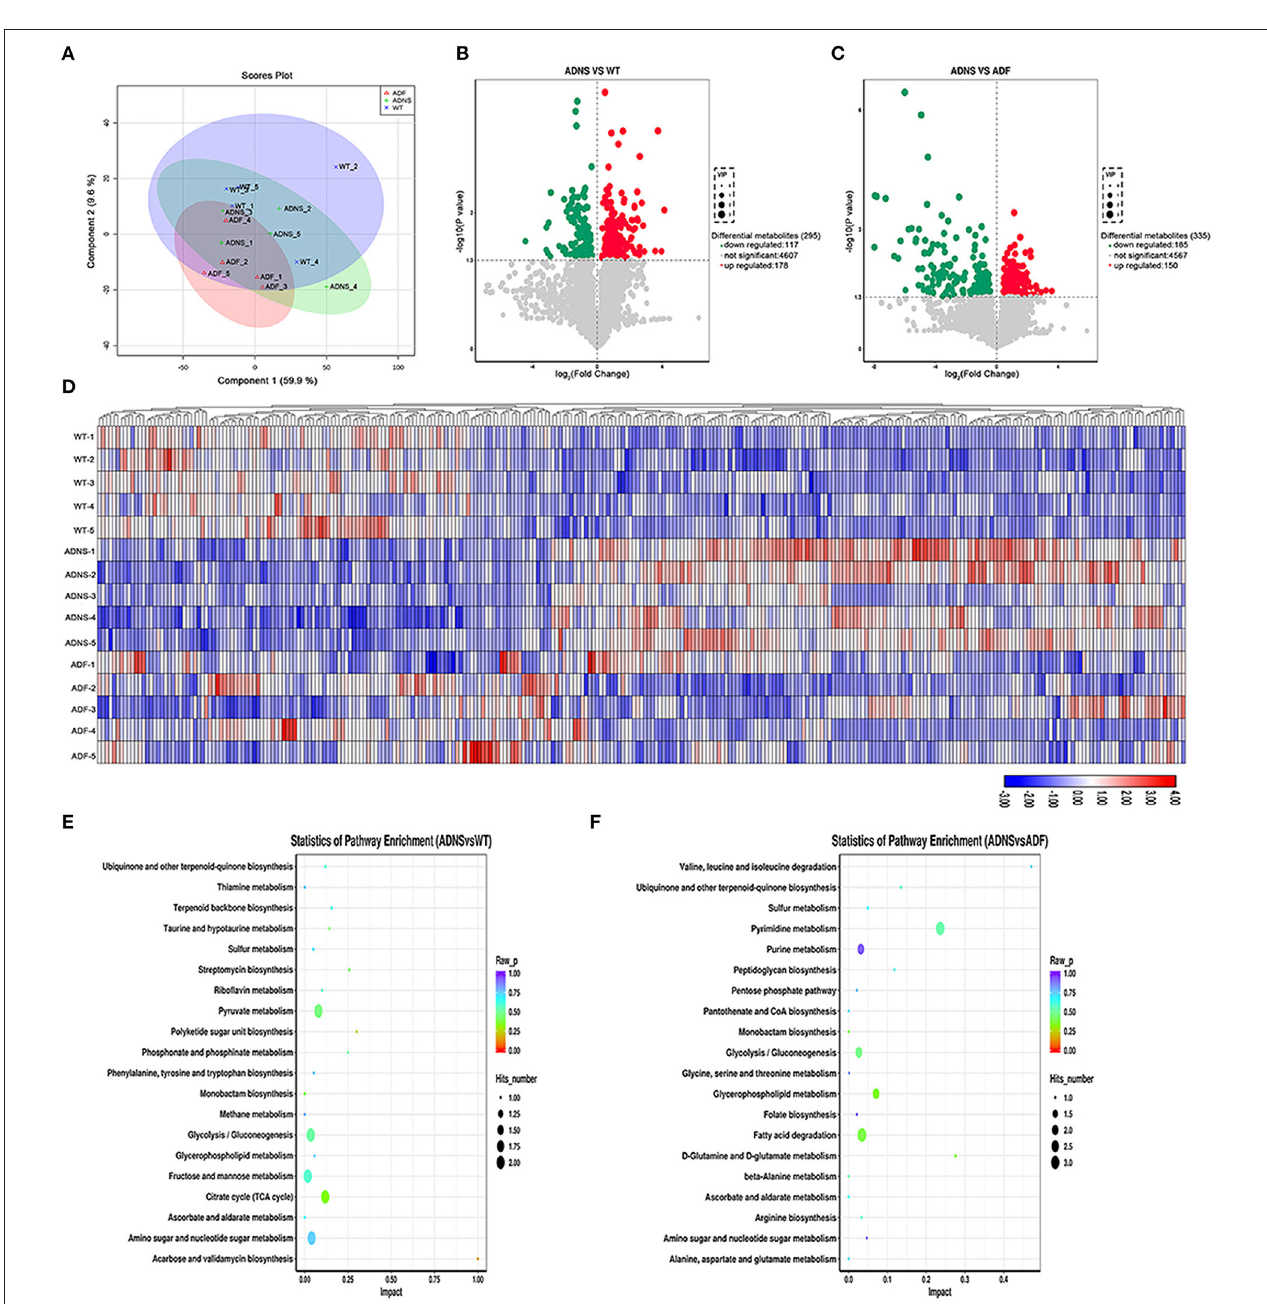
FIGURE 6 | Intestinal metabolite alteration of APP/PS1 mice treated with fasudil. (A) The PLS-DA score plots of metabolic profiles in WT (blue) and APP/PS1 mice treated with saline (ADNS, in green), or fasudil (ADF, in red). The separation trend of metabolic changes was observed in ADNS, WT and ADF; all samples were analyzed with 95% confidence interval (CI). (B,C) Volcano diagram of the changes in metabolites in WT, ADNS, and ADF mice. There were 295 metabolites differentially expressed in ADNS vs WT (B) , including 117 metabolites significantly downregulated (green) and 178 metabolites significantly upregulated (red) (metabolites with non-significant differences are shown in gray). In addition, there were 335 metabolites differentially expressed in ADF vs. ADNS (C) , including 185 downregulated metabolites and 150 upregulated metabolites. Each point in the volcano diagram represents a single metabolite. The scatter color represents the final screening result. (D) The heat map by the Hierarchical Clustering Analysis for different comparison combinations with significant changes. ADNS (middle 1–5) was presented in a different color pattern relative to WT (upper 1–5), which was similar to ADF (lower 1–5). (E,F) Analysis of the top 20 metabolic pathways in comparison combinations according to the impact factors (bubble plot). The results of the metabolic pathway analysis were presented as bubble plots. The bubble color represents the p value of the enrichment analysis, while the size of the point represents the number of different metabolites enriched in the pathway. Compared to WT, ADNS was focus on the metabolisms of pyruvate, glycolysis/gluconeogenesis, fructose, mannose, citrate cycle (TCA cycle), amino sugar, and nucleotide sugar; compared to ADNS, ADF was focused on the metabolisms of pyrimidine, purine, glycolysis/gluconeogenesis, glycerophospholipid, and fatty acid degradation; n = 5.